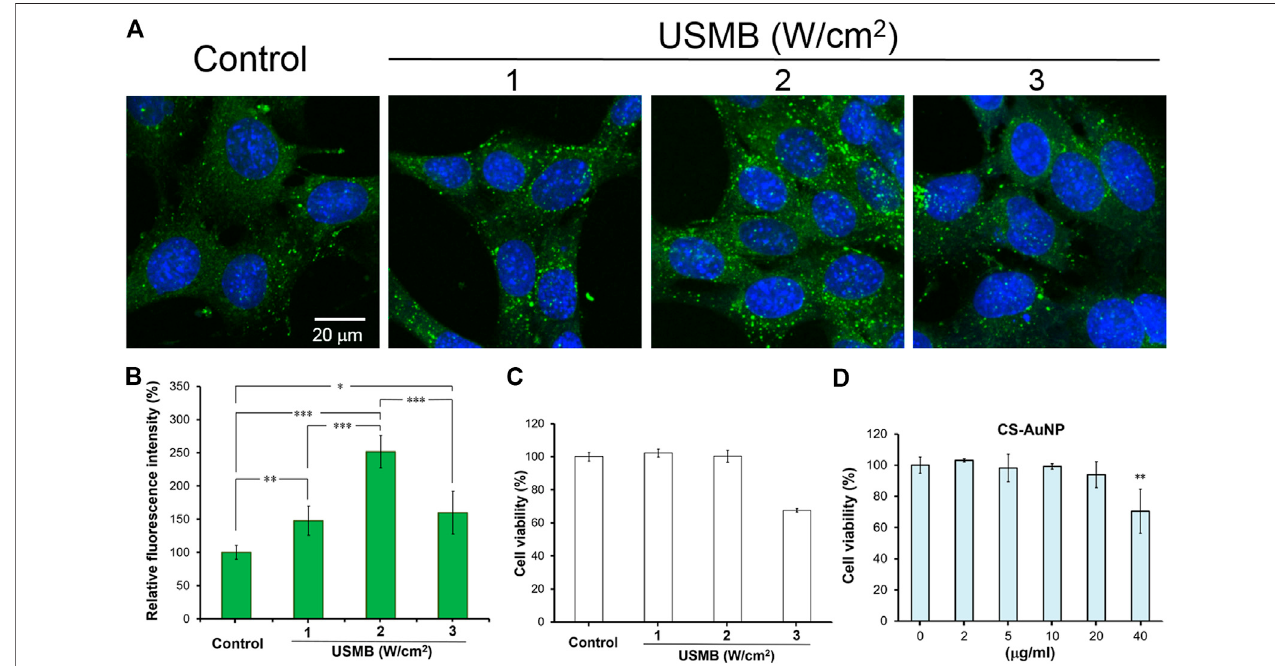
FIGURE 3 | Comparison of the permeability difference of the HEI-OC1 cells following FITC-CS-AuNP treatments with or without prior USMB exposure. Fluorescence images of (A) HEI-OC1cells after 24-h incubation with FITC-CS-AuNPs at a concentration of 10 μ g/ml. Prior to FITC-CS-AuNP treatment, three consecutive USMB exposures (1 min/exposure) at 1 MHz frequency and an acoustic intensity of 1, 2, or 3 W/cm 2 were conducted. (B) Quantitative analysis of cellular uptake of FITC-CS-AuNPs by HEI-OC1 cells. (C) WST-1 assay of the HEI-OC1 cells after exposure to various intensities of US with MBs for 24 h. Control corresponds to cells without USMB treatment. (D) WST-1 assay of the HEI-OC1 cells after incubation with various concentrations of CS-AuNP for 24 h. Control corresponds to cells in the culture medium without CS-AuNPs. * p < 0.05, ** p < 0.01, *** p < 0.001. USMB, ultrasound microbubble; CS-AuNPs, chitosan-coated gold